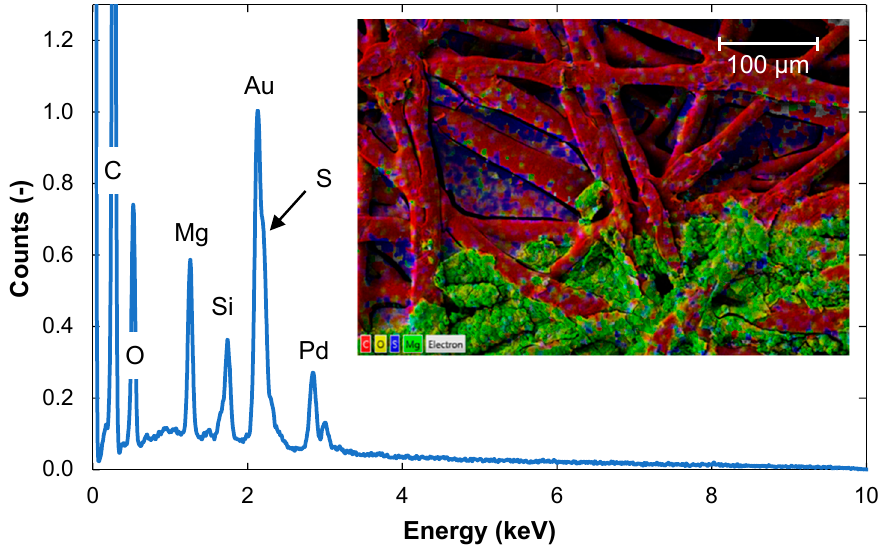
Figure 5. EDS spectrum obtained from the backing of the fouled membrane. A SEM image of the membrane surface is shown in the insert. The elements present and normalization are as described in Figure 2.